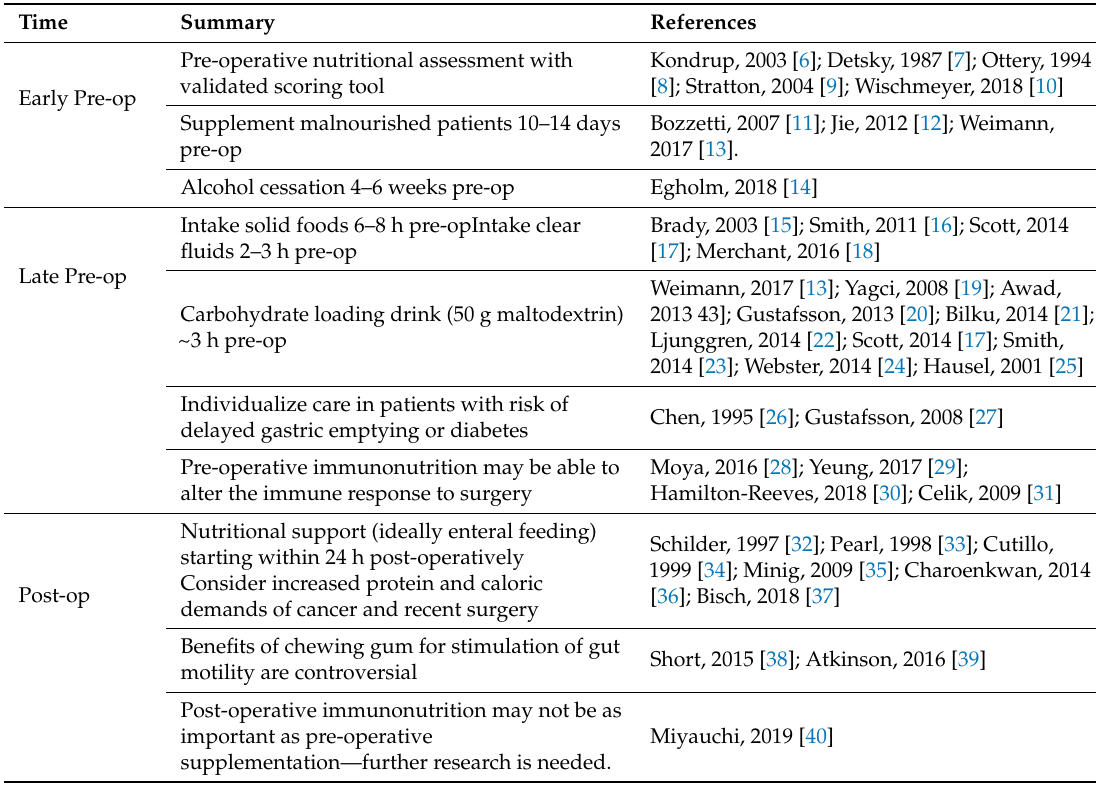
Table 1. Summary of